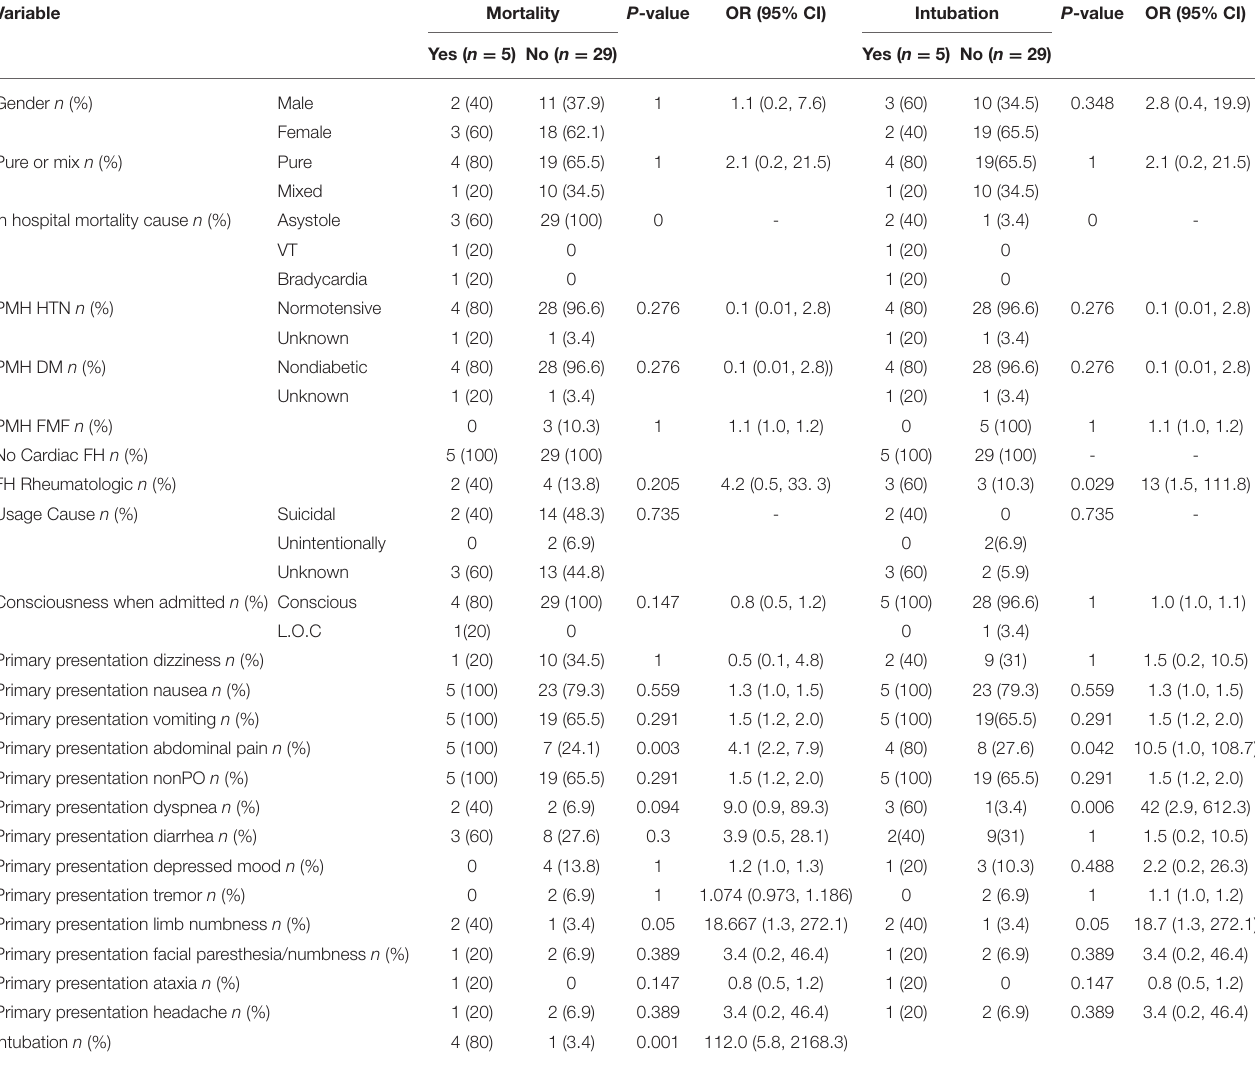
TABLE 2 | Patient history and primary symptoms in mortality and mechanical ventilation groups (qualitative variables). Variable